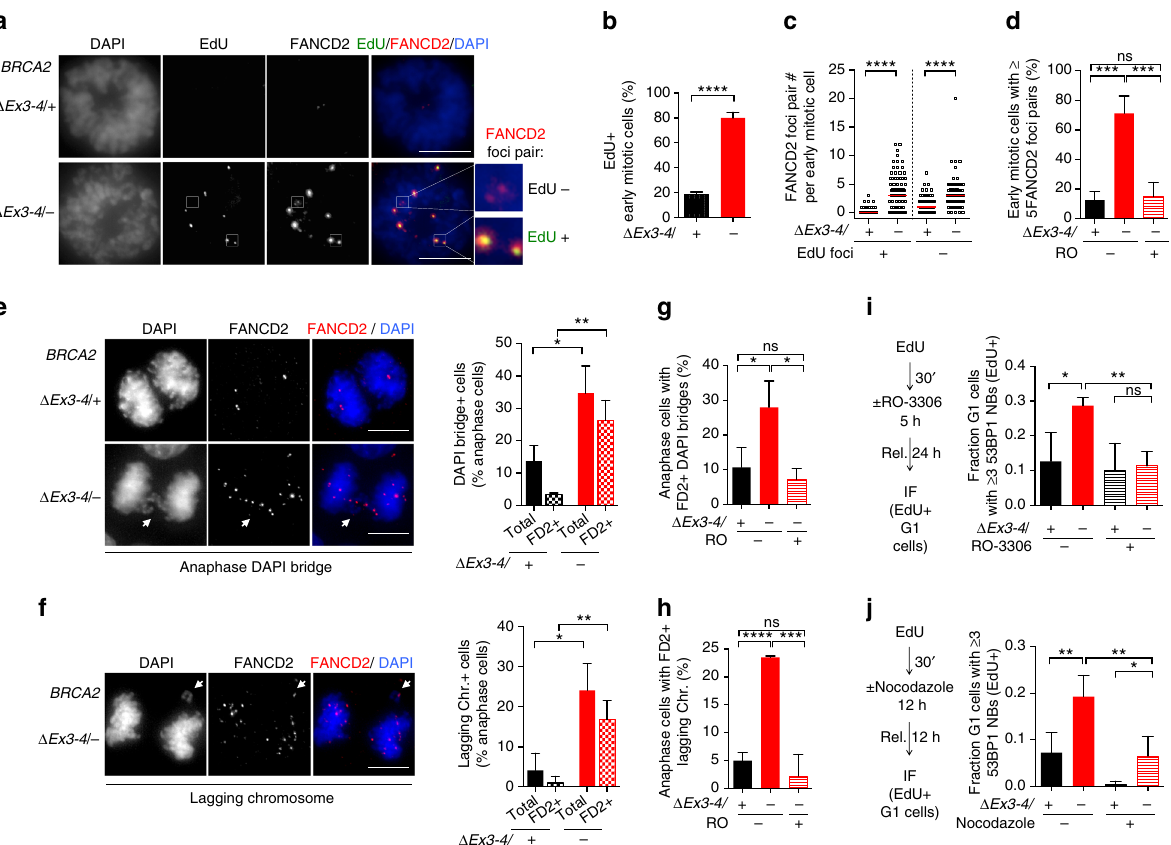
Fig. 5 BRCA2 de fi ciency causes DNA under replication that results in abnormal mitoses. a – c BRCA2 Δ Ex3-4/ – cells were released for 22 h from serum starvation to increase mitotic cells, incubated with EdU for 1 h, and then analyzed for mitotic DNA synthesis. Early mitotic cells de fi ned as being in prophase, prometaphase, or metaphase were analyzed for EdU foci that co-localize with FANCD2 foci pairs. a Representative images of mitotic DNA synthesis. Scale bars 10 µ m. b Percent early mitotic cells containing EdU foci, analyzed by an unpaired two-tailed t -test. n = 3. c FANCD2 foci pairs with or without EdU foci co-localization. Graphs represent the pooled results of three independent experiments, each analyzed by a two-tailed Mann – Whitney test. Median FANCD2 foci pair number, red bars . d FANCD2 foci pair analysis in early mitotic cells. Cells were untreated, or treated with the CDK1 inhibitor RO-3306 (10 µ M, 24h) to delay mitotic entry, and released for 1 h before analysis of FANCD2 foci pairs in early mitotic cells. Analysis is by an unpaired two-tailed t -test. n = 4. e – h Anaphase cells were analyzed for DAPI bridges ( e , g ) and lagging chromosomes ( f , h ). RO-3306 treatment (10 µ M, 24h with release for 1h) was applied where indicated. Representative deconvolved images are shown on the left of e and f . n = 3. Statistical analysis was by an unpaired two-tailed t -test. FD2, FANCD2. Scale bars 10 µ m. i , j . 53BP1 nuclear body analysis with RO-3306 (10 µ M, i ) or nocodazole (100 ng ml − 1 , j ) treatment and released as in the schematic on the left . The fraction of EdU+ cells in G1 at the time of harvest that contains ≥ 3 53BP1 nuclear bodies (NBs) is shown in the graph on the right . Analysis is by an unpaired two-tailed t -test. n ≥ 3. Error bars s.d. ns, not signi fi cant; * p < 0.05; ** p < 0.01; *** p < 0.001; **** p <